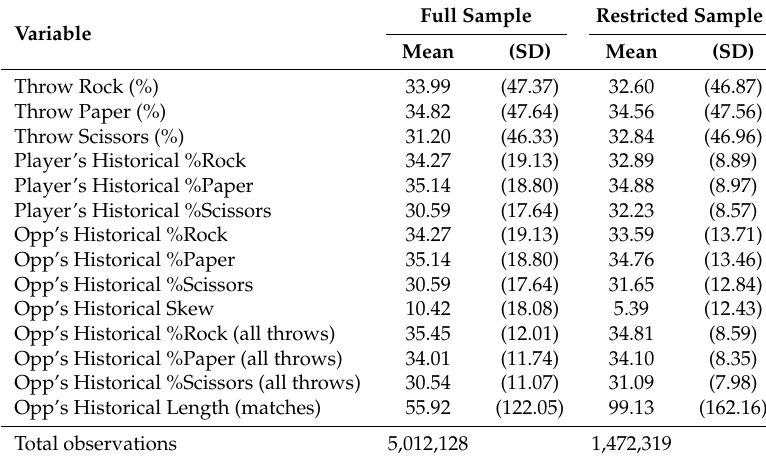
Figure 2. Number of matches played by Roshambull users. Note: The figure shows the number of clean matches played by the 334,661 players who had at least one clean, completed match (see Footnote 11 for a description of the data cleaning). The data has a very long right tail, so all the players with over 200 matches are grouped together in the right-most bar. Table 1. Summary Statistics of First